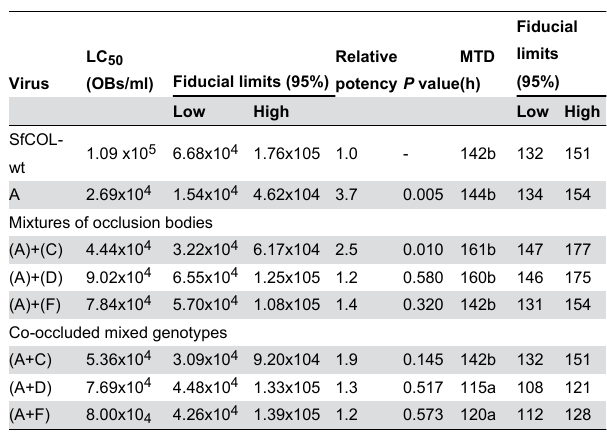
Table 2. Estimated LC values, relative potencies and 50 mean time to death (MTD) values of SfCOL-wt, SfCOL-A OBs alone, mixtures of OBs, and co-occluded genotype mixtures, in similar proportions, in Spodoptera frugiperda second